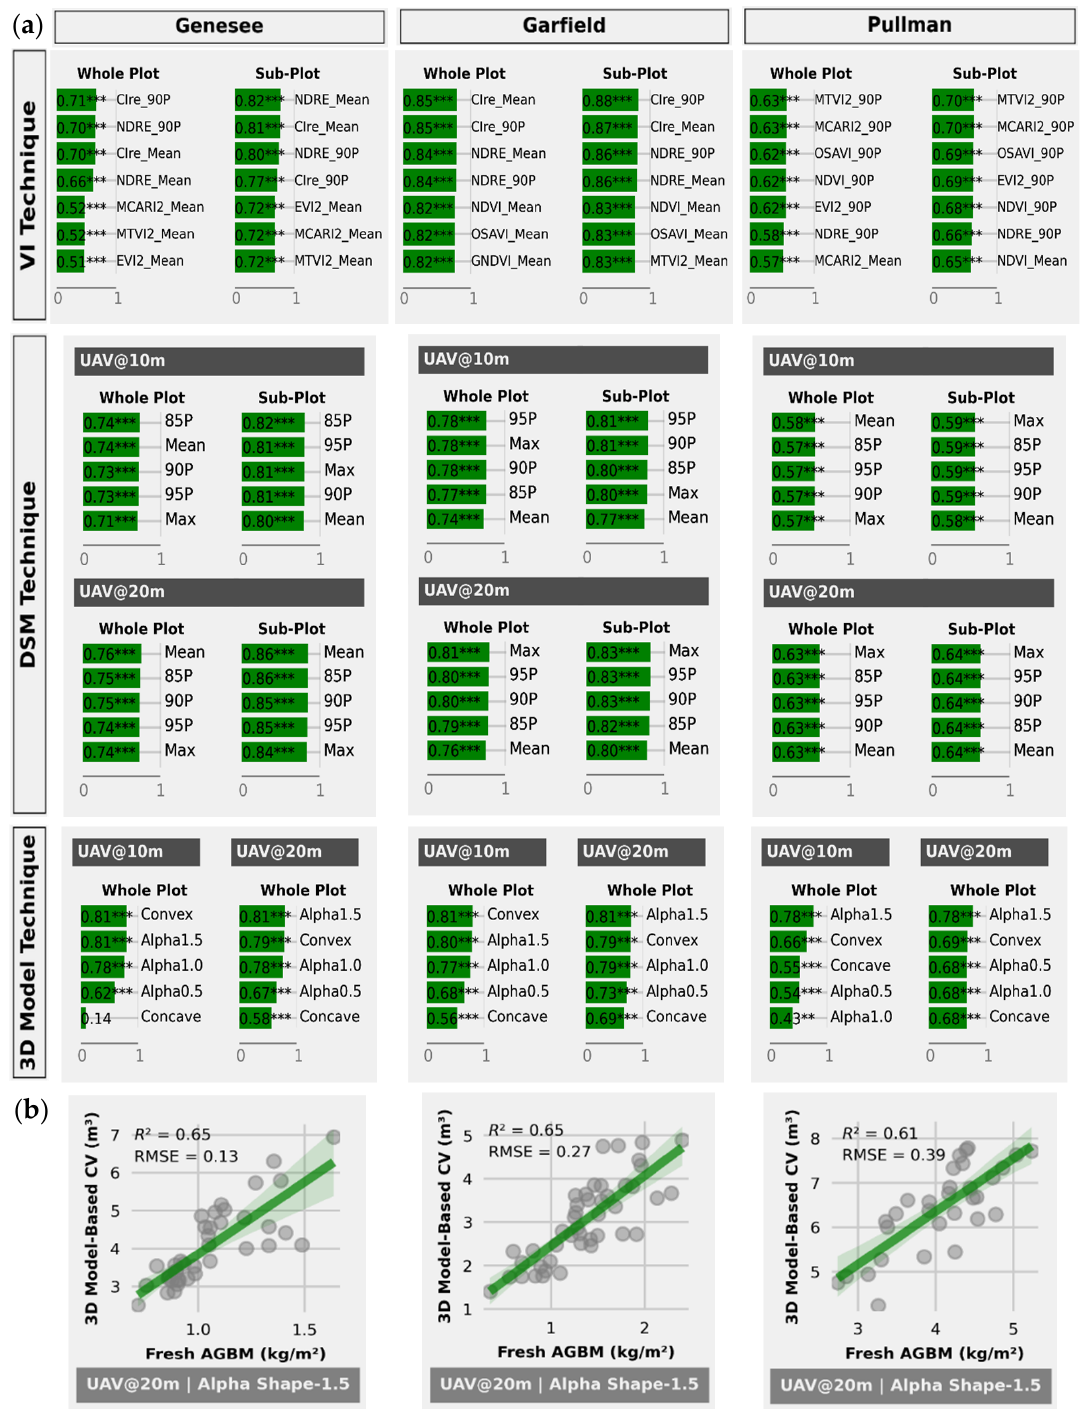
Figure 6. Relationships between ground reference data and digital canopy volume traits (at F50 stage) extracted from UAV imagery from three trials at Genesee, Garfield, and Pullman: ( a ) correlation coefficients based on digital traits extracted from VI imagery, DSM, and point cloud data; ( b ) linear regression between 3D-model-based alpha-shape ( α = 1.5) CV and ground reference data. CV : canopy volume; VI technique —90P: 90th percentile of VI; Mean: average VI; 3D model technique — Alpha1.5: alpha shape ( α = 1.5); Alpha1.0: alpha shape ( α = 1.0); Alpha0.5: alpha shape ( α = 1.5); Concave: concave hull; Convex: convex hull. Significant probability level: ** 0.01, and *** 0.001.